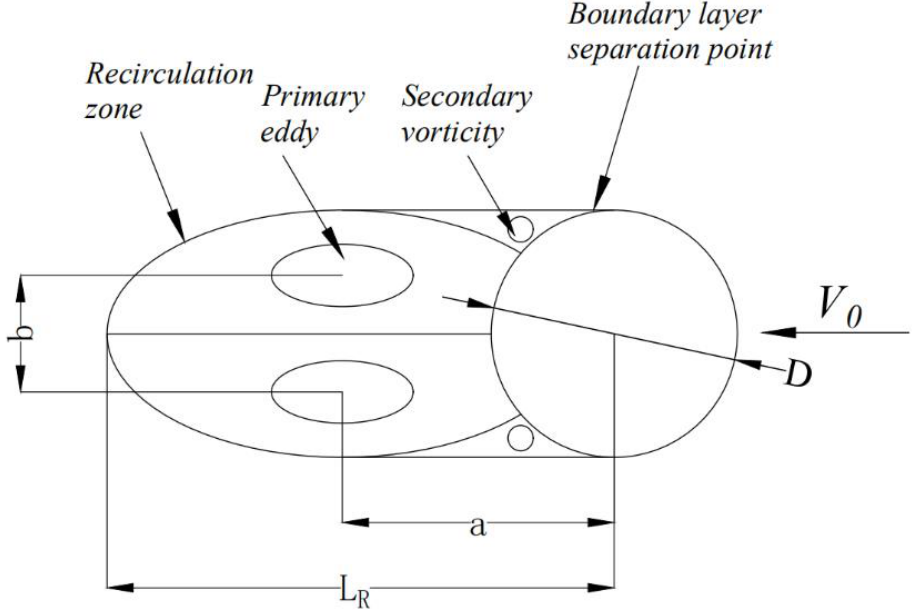
Figure 11. A schematic sketch of the recirculation zone.